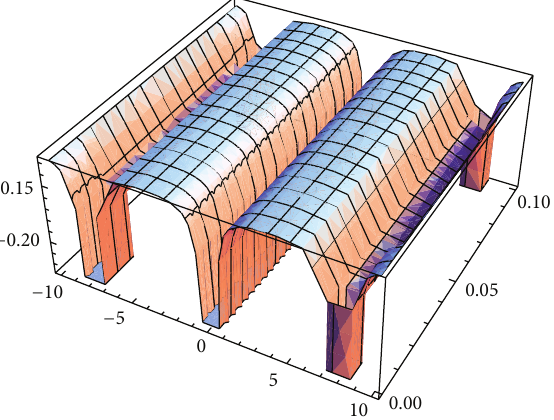
Figure 1: Travelling waves solutions (26) are plotted: periodic solitary waves.